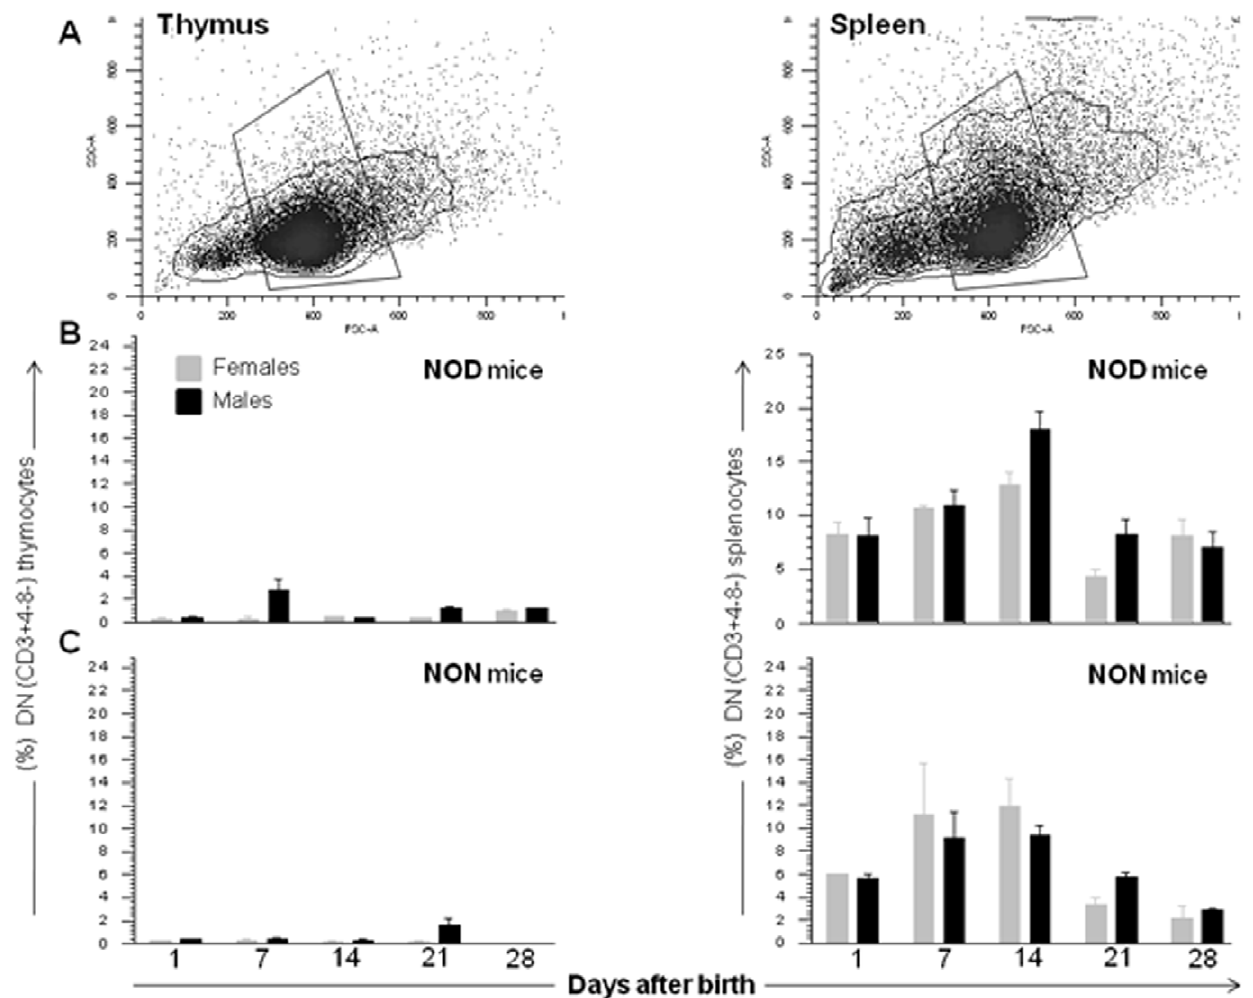
Figure 1. Frequency of NOD DNCD3 thymic and splenic cells. Total thymocytes and splenocytes from individual NOD and NON.NOD control males and females were harvested at various time-points after birth, stained with CD3-PE, CD4-PE-Cy7, and CD8-PerCP mAb-conjugates, and the frequency of CD3 + 4 2 8 2 (DNCD3) cells was measured by FACS. Panel A , cells gated based on the forward and light scatter to identify viable populations. Panel B , kinetics of thymic vs . splenic DNCD3 cell development in newborn NOD mice. Panel C , kinetics of thymic vs . splenic DNCD3 cell development in newborn NON.NOD control mice. Shown are the individual variations (mean 6 SD) in each age group.